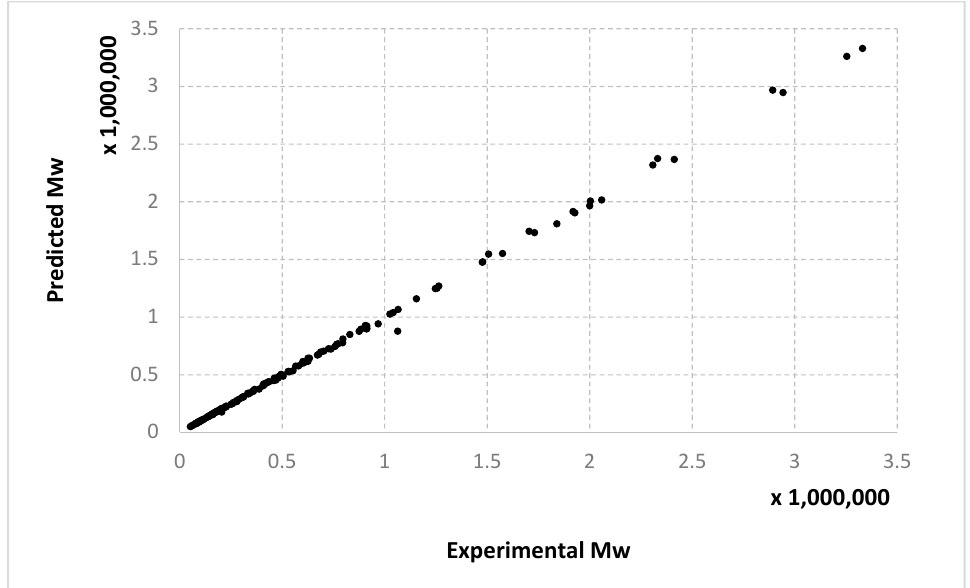
Figure 12. Predicted gravimetrical average molecular weight with the LMNNR-EA algorithm versus experimental data, setting 2, with data split into 90% for training and 10% for testing.